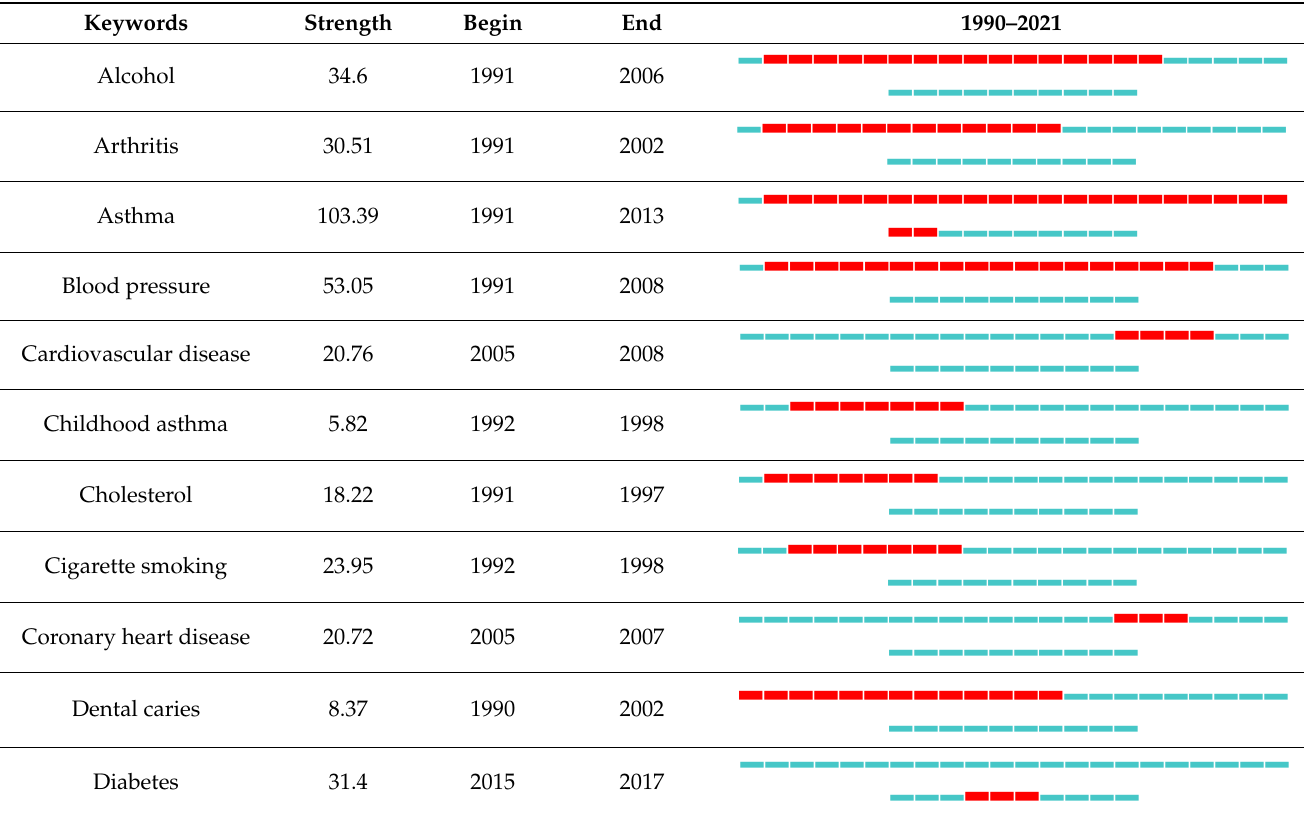
Table 3. Keyword bursts for disorders explored in patient education research.